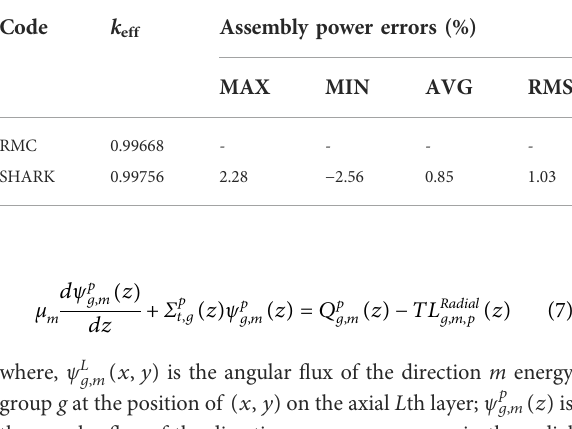
FIGURE 10 Radial pin power deviations in Macroscopic BEAVRS core problem.